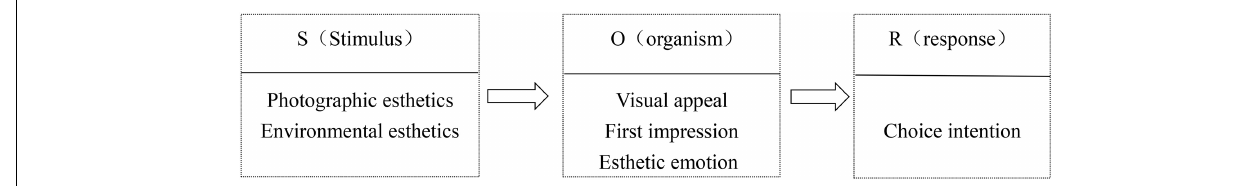
FIGURE 1 | Research framework based on the stimulus-organism-response (S-O-R) framework.